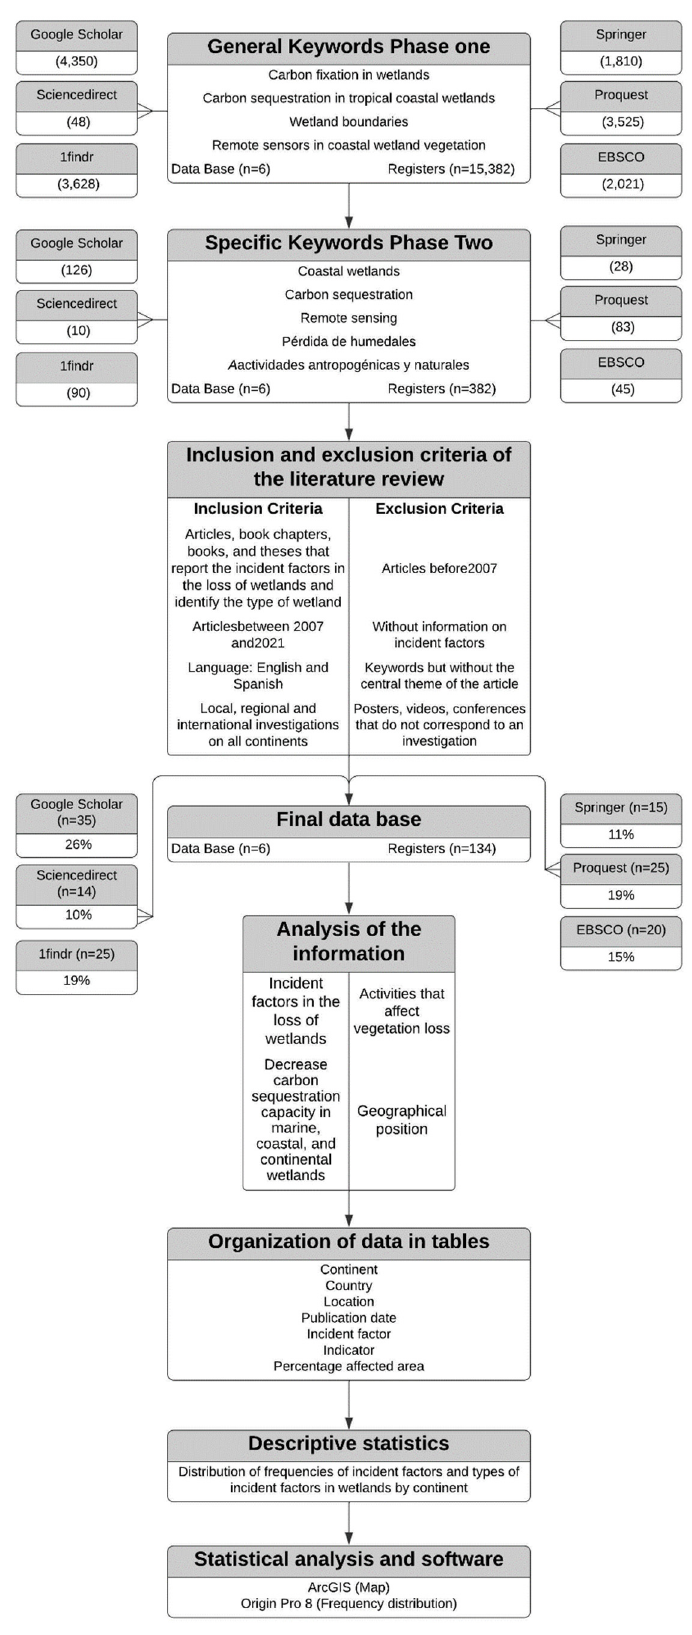
Figure 1. Methodology for the literature review.